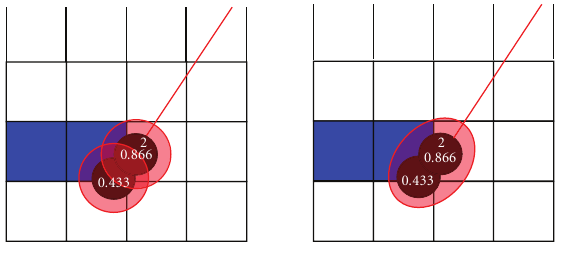
Figure 14: Plausible regions of